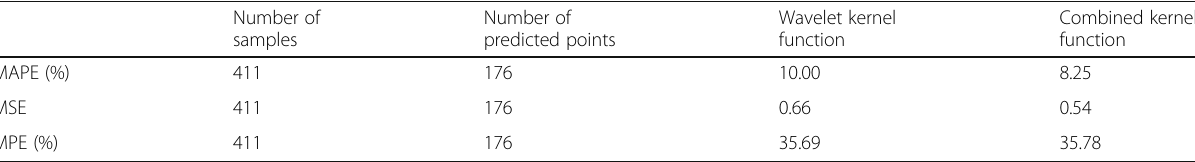
Table 3 A comparison of the prediction error between the wavelet kernel function and combined kernel function for 587 samples Number of Number of samples predicted